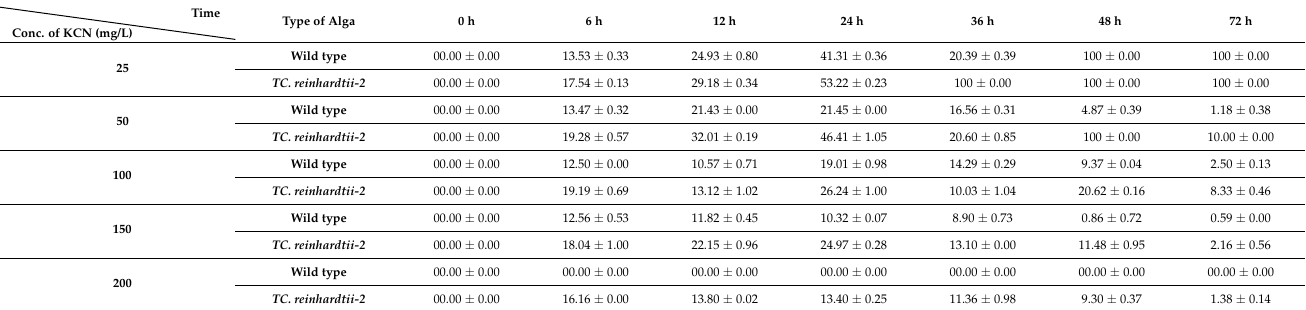
Table 1. Percentage of cyanide removal by wild-type and TC. reinhardtii—2 lines